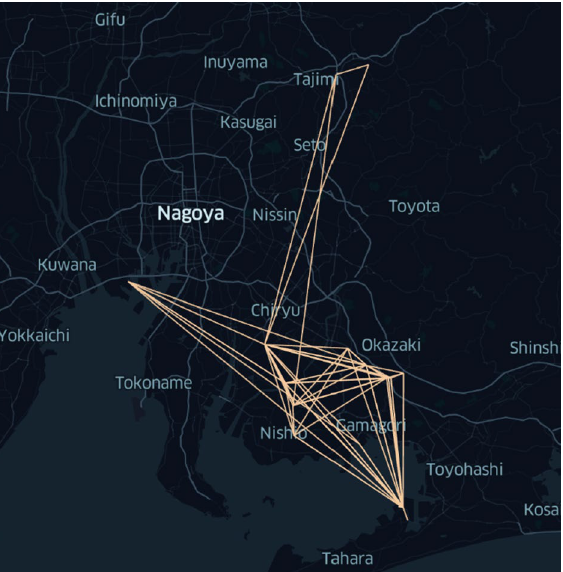
Figure 6. Connectivity graph for routes currently used by Aisin Corporation. Lines indicate pairs of the 23 nodes that trucks drive between in the routes determined by Aisin Corporation logistics experts. For this routing, 142 trucks deliver approximately 340,000 boxes containing ∼ 15, 000 unique parts. Among these parts,